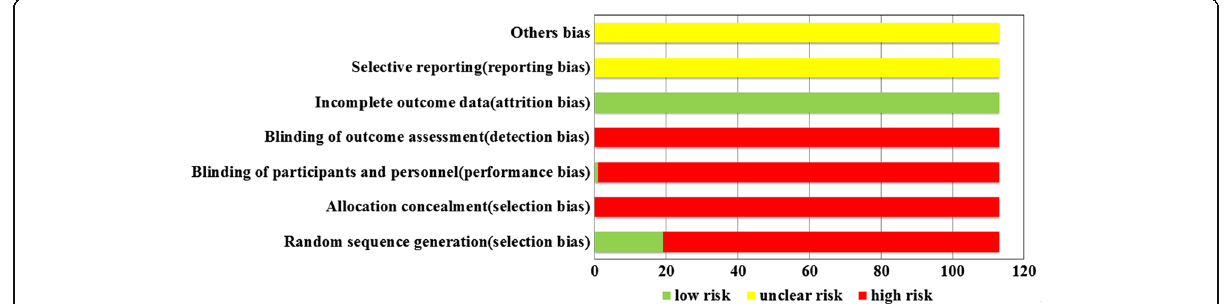
in Table 3. SFI + WM vs SMI + WM (MD = 80.17, 95% CIs: 16.67 – 147.5), SFI + WM vs SQFZI+WM (MD